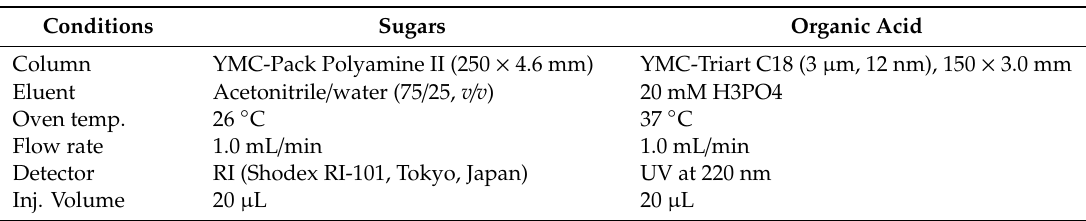
Table 1. Conditions of high-performance liquid chromatography (HPLC) for analyzing sugars and organic acids.